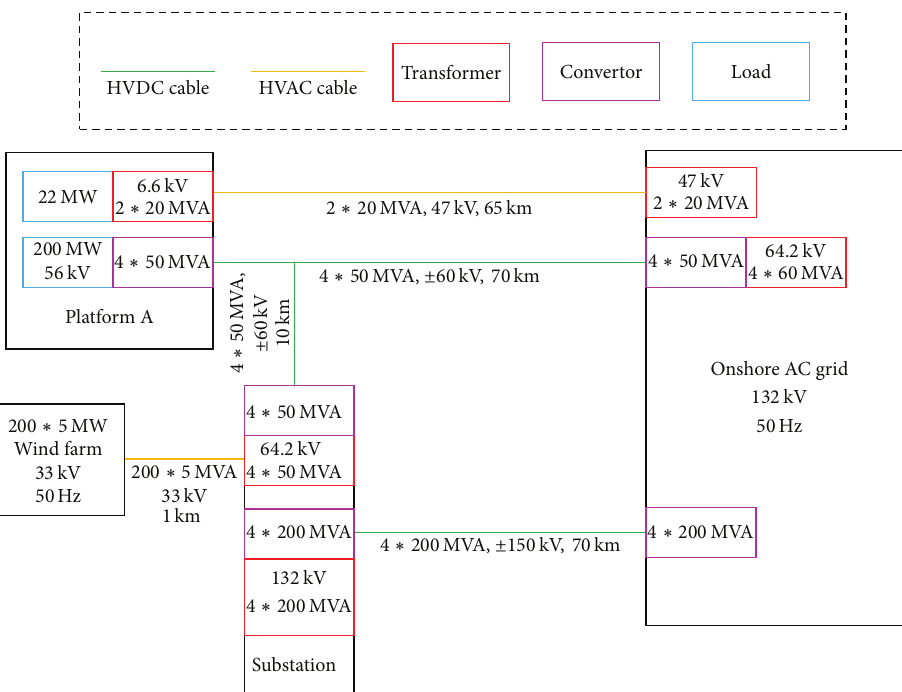
Figure 12: Proposed 1000MW wind farm integration electrical